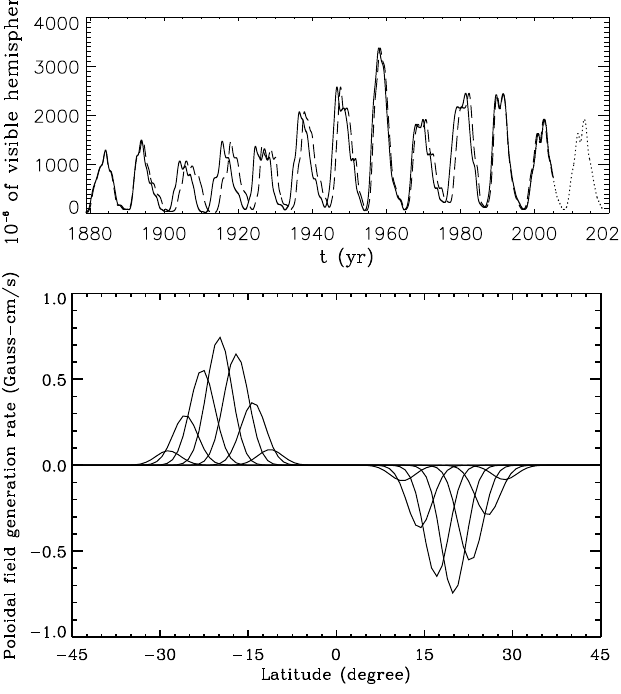
Fig. 4. (a) sunspot area data stretched and compressed (dashed curve) in time to equalize all solar cycle periods to 10.75 years, compared to original data (solid curve); (b) Gaussian profiles used to represent latitude width of sunspot zone at various phases of a sunspot cycle.